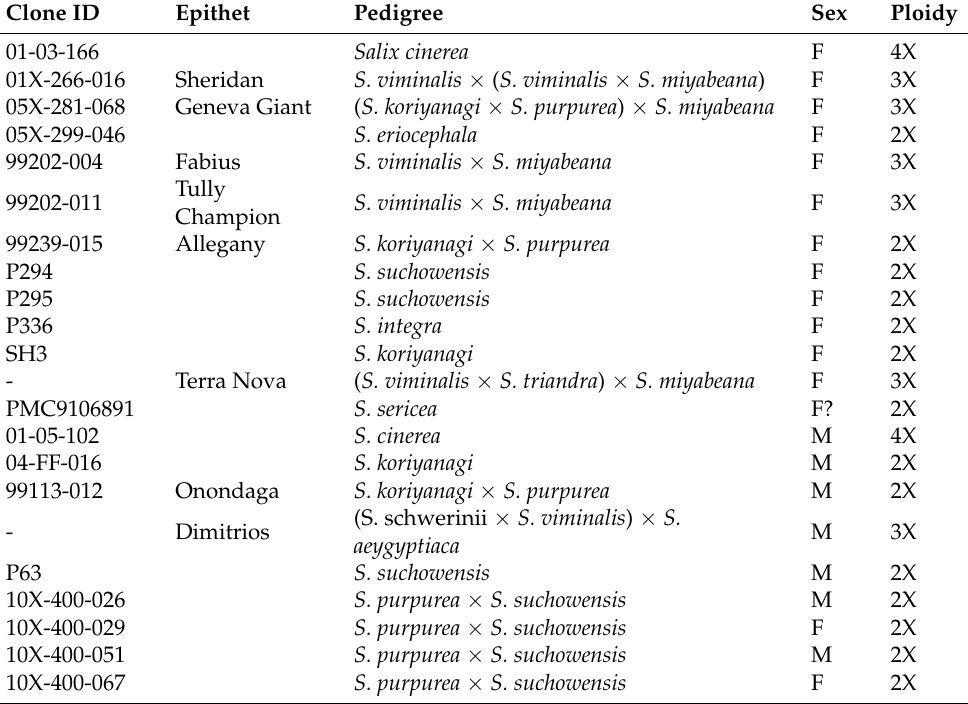
Table A1. Pedigree, sex, and ploidy of 50 selected shrub willow genotypes for the greenhouse screening